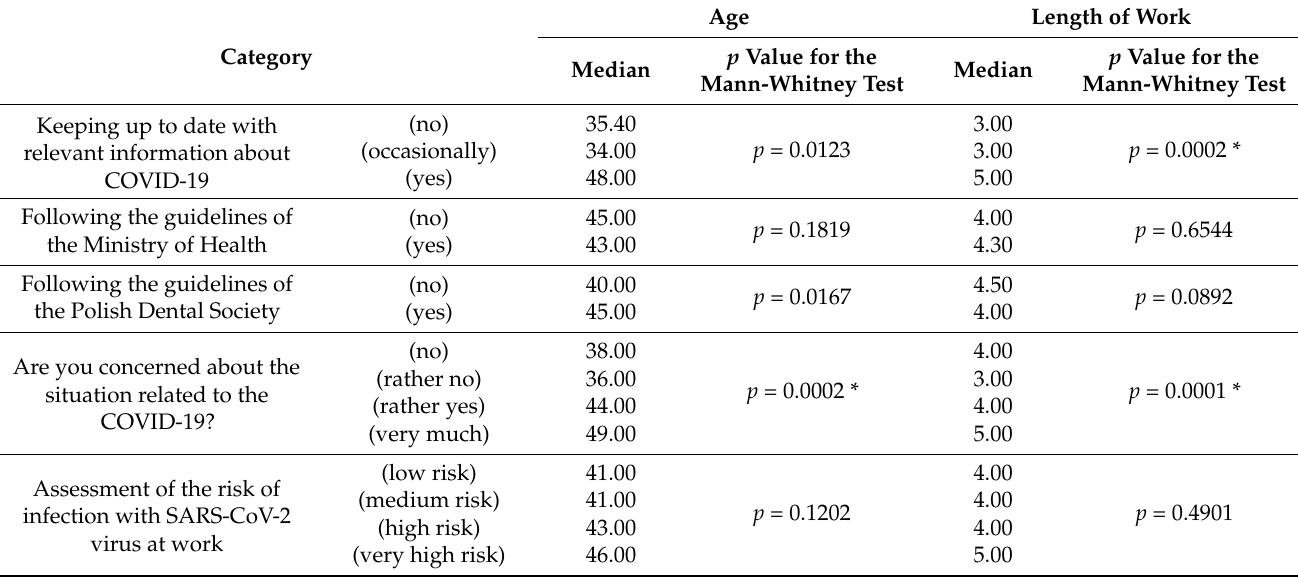
Table 7. Relationships between age, length of work and selected parameters, evaluated using the Mann-Whitney test.